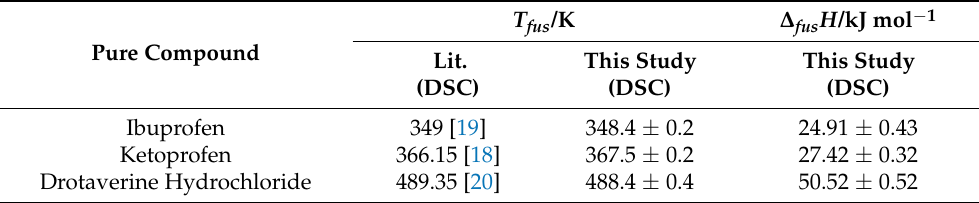
Table 1. Melting temperatures and enthalpy of fusion of APIs